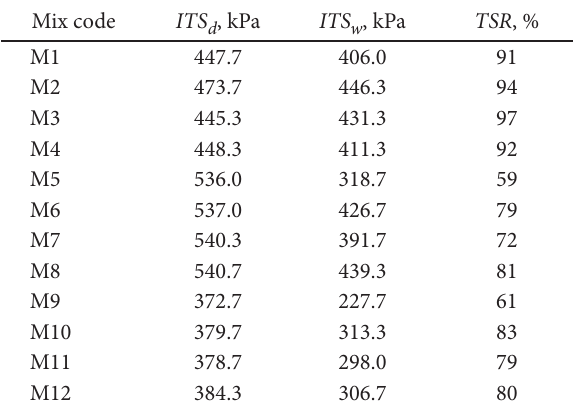
Table 4. Moisture susceptibility test